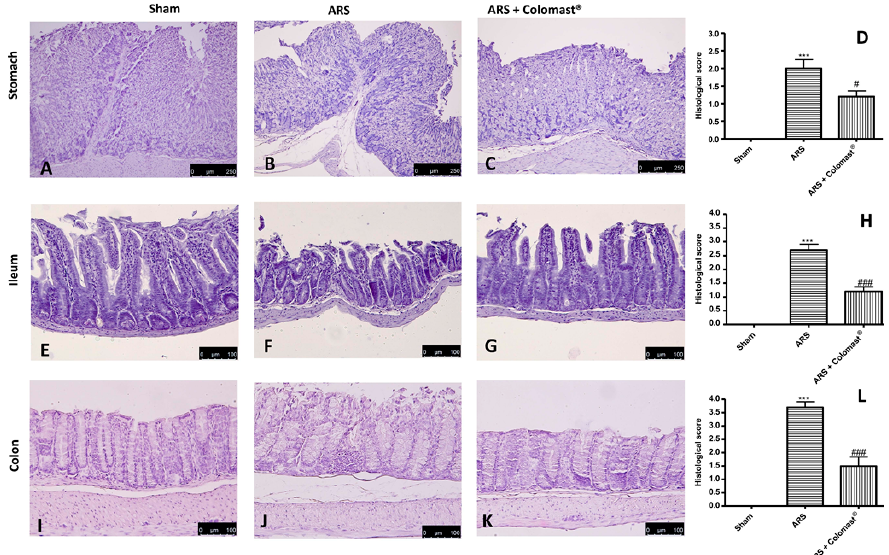
Figure 2. Effect of Colomast ® pre-treatment on histological damage. Histological evaluation of stomach: sham ( A ); Acute restraint stress (ARS) ( B ); Colomast ® ( C ); histological score ( D ). Histological evaluation of ileum: sham ( E ); ARS ( F ); Colomast ® ( G ); histological score ( H ). Histological evaluation of colon: sham ( I ); ARS ( J ); Colomast ® ( K ); histological score ( L ). Images are figurative of at least three independent experiments. Values shown are means ± SEM of six animals in each group. For the histology, a 10× magnification is shown (250-µm scale bar) for stomach; a 20× magnification is shown (100-µm scale bar) for ileum and colon. *** p < 0.001 vs. sham; # p < 0.05 vs. ARS group; ### p < 0.001 vs. ARS group.